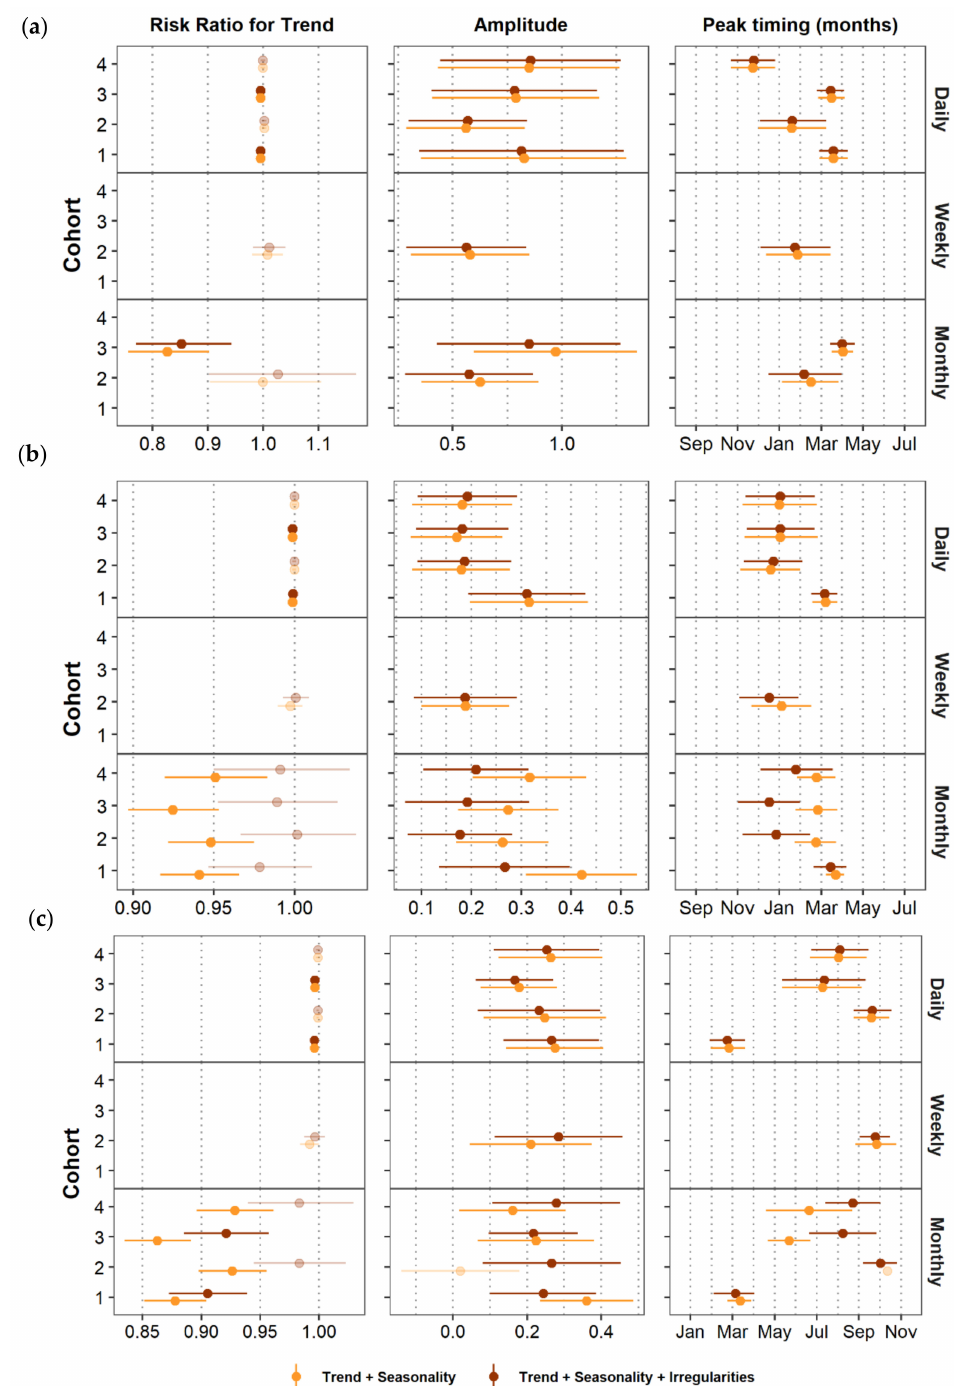
Figure 10. E ff ect of omitting aggregation irregularities on estimates and confidence intervals for trend, amplitude, and peak timing of ( a ) ALRI, ( b ) AURI, and ( c ) diarrhea for all aggregation levels. Faded symbols indicate estimates that had a p -value > 0.05. The confidence interval for peak timing of monthly Cohort 2 data is not shown since it was calculated as 305